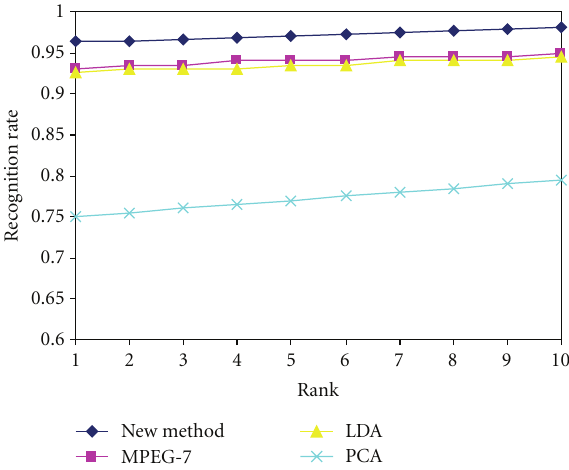
Figure 8: CMS results for the Yale database.